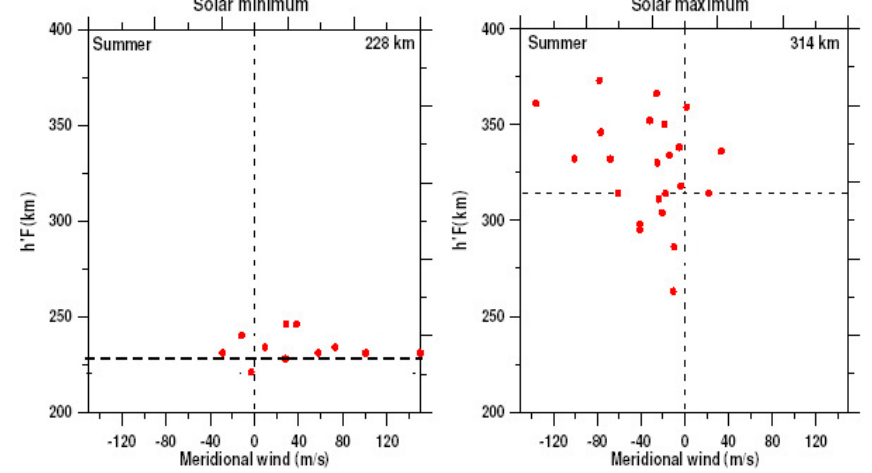
Fig. 1a. Scatter plot of meridional wind and h 0 F prior to triggering of ESF for summer solstice of solar minimum (left panel) and solar maximum (right panel).